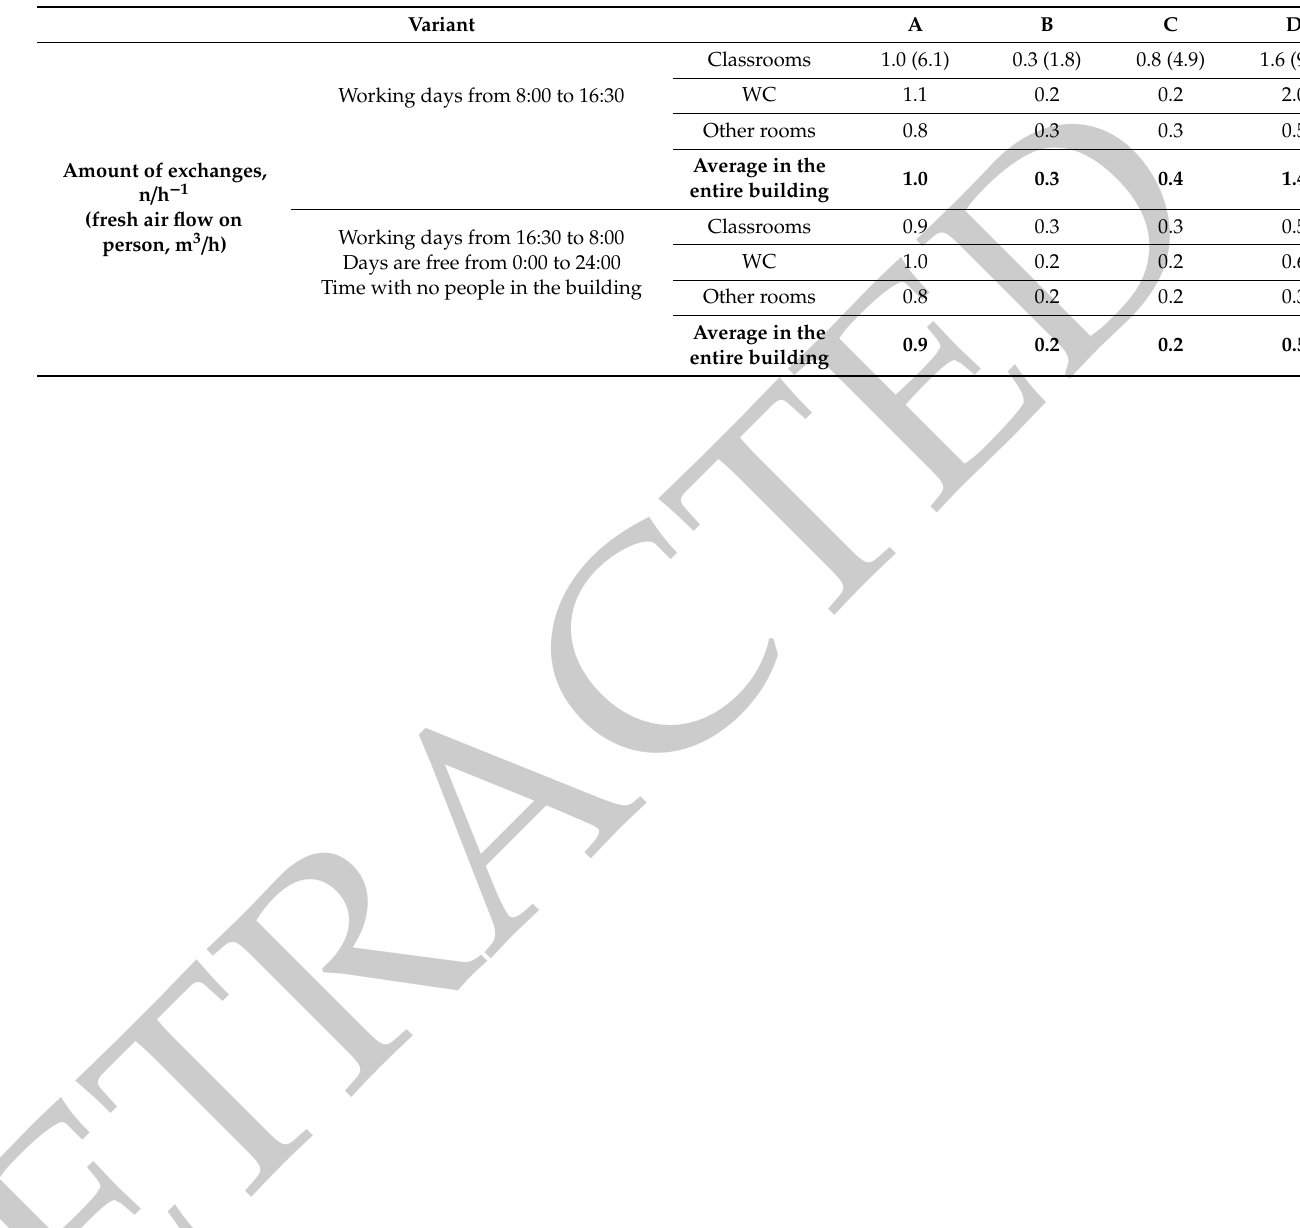
Table 1. Amount of ventilation air changes in the